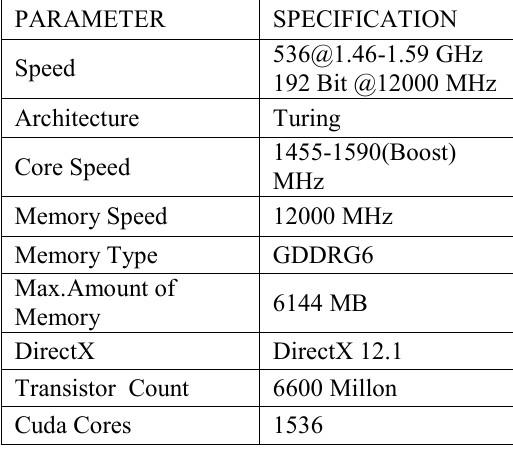
Table 1: NVIDIA GTX 1660Ti GPU Specifications CPU Specification :